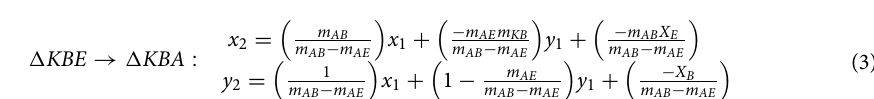
Figure 5. Simulation results of non-closed carpet cloak. ( a , b ) Near field distributions and far field scattering pattern of the target with sound hard boundaries that is located on the reflecting plane. The scattered field of reflecting plane is disturbed in the presence of the target. ( c , d ) Near field distributions and far field scattering pattern of the conventional carpet cloak. ( e , f ) Near field distributions and far field scattering pattern of the target near the non-closed carpet cloak. The non-closed device restored the scattering pattern of the object as well as the reflecting plane. It is also similar to field distribution of the conventional structure, which illustrates the validity of the fenestrated carpet